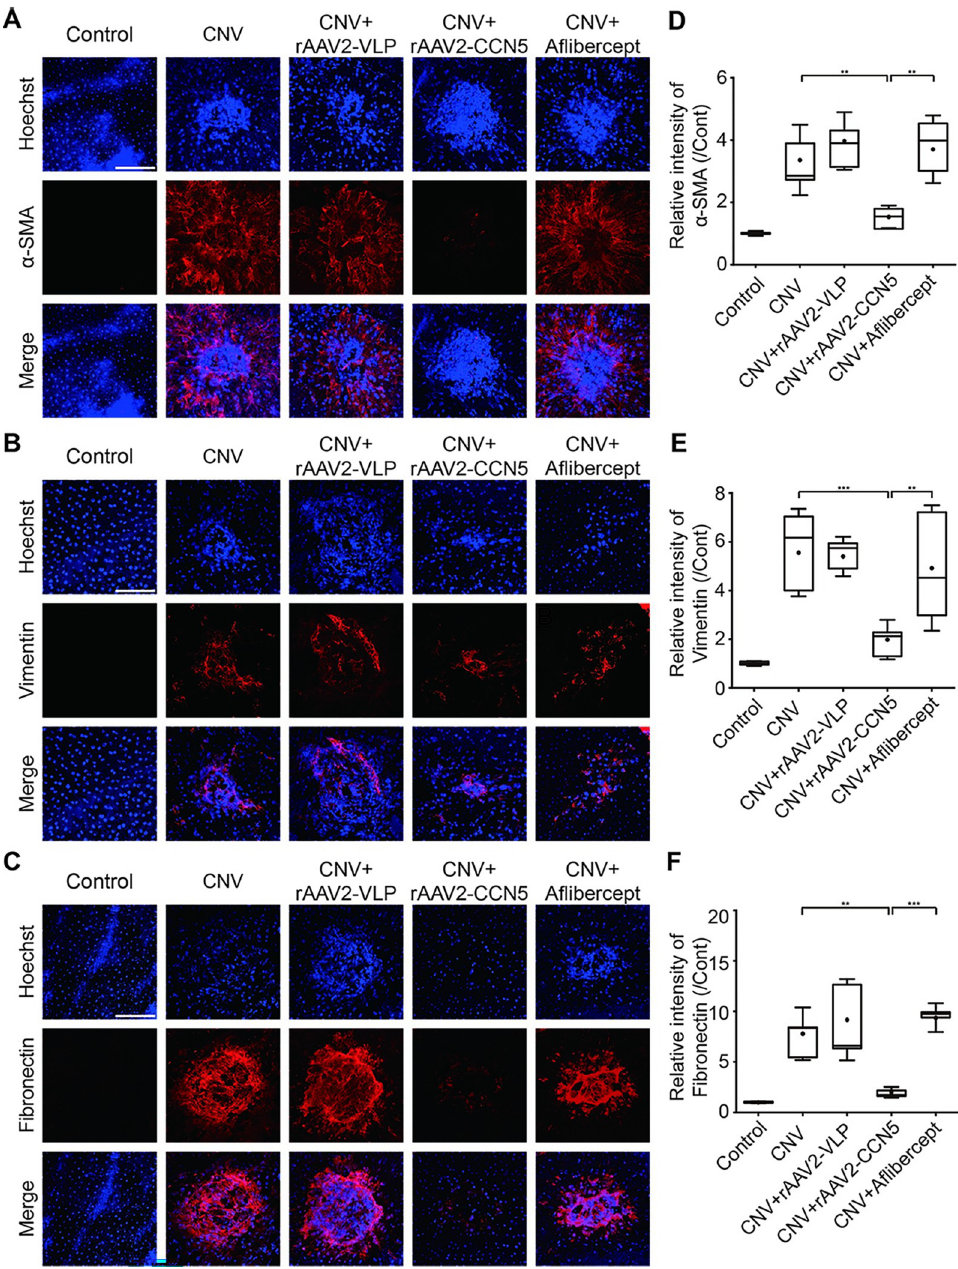
bar, 100 μ m. (D-F). α -SMA-, vimentin-, and fibronectin-positive areas were captured and their intensities were calculated using Leica confocal software and plotted. Bars show the mean ± SD. (D, n = 6 spots per group; E, n = 7 spots per group; F, n = 5 spots per group; one-way ANOVA; �� p < 0.01, ��� p < 0.001).